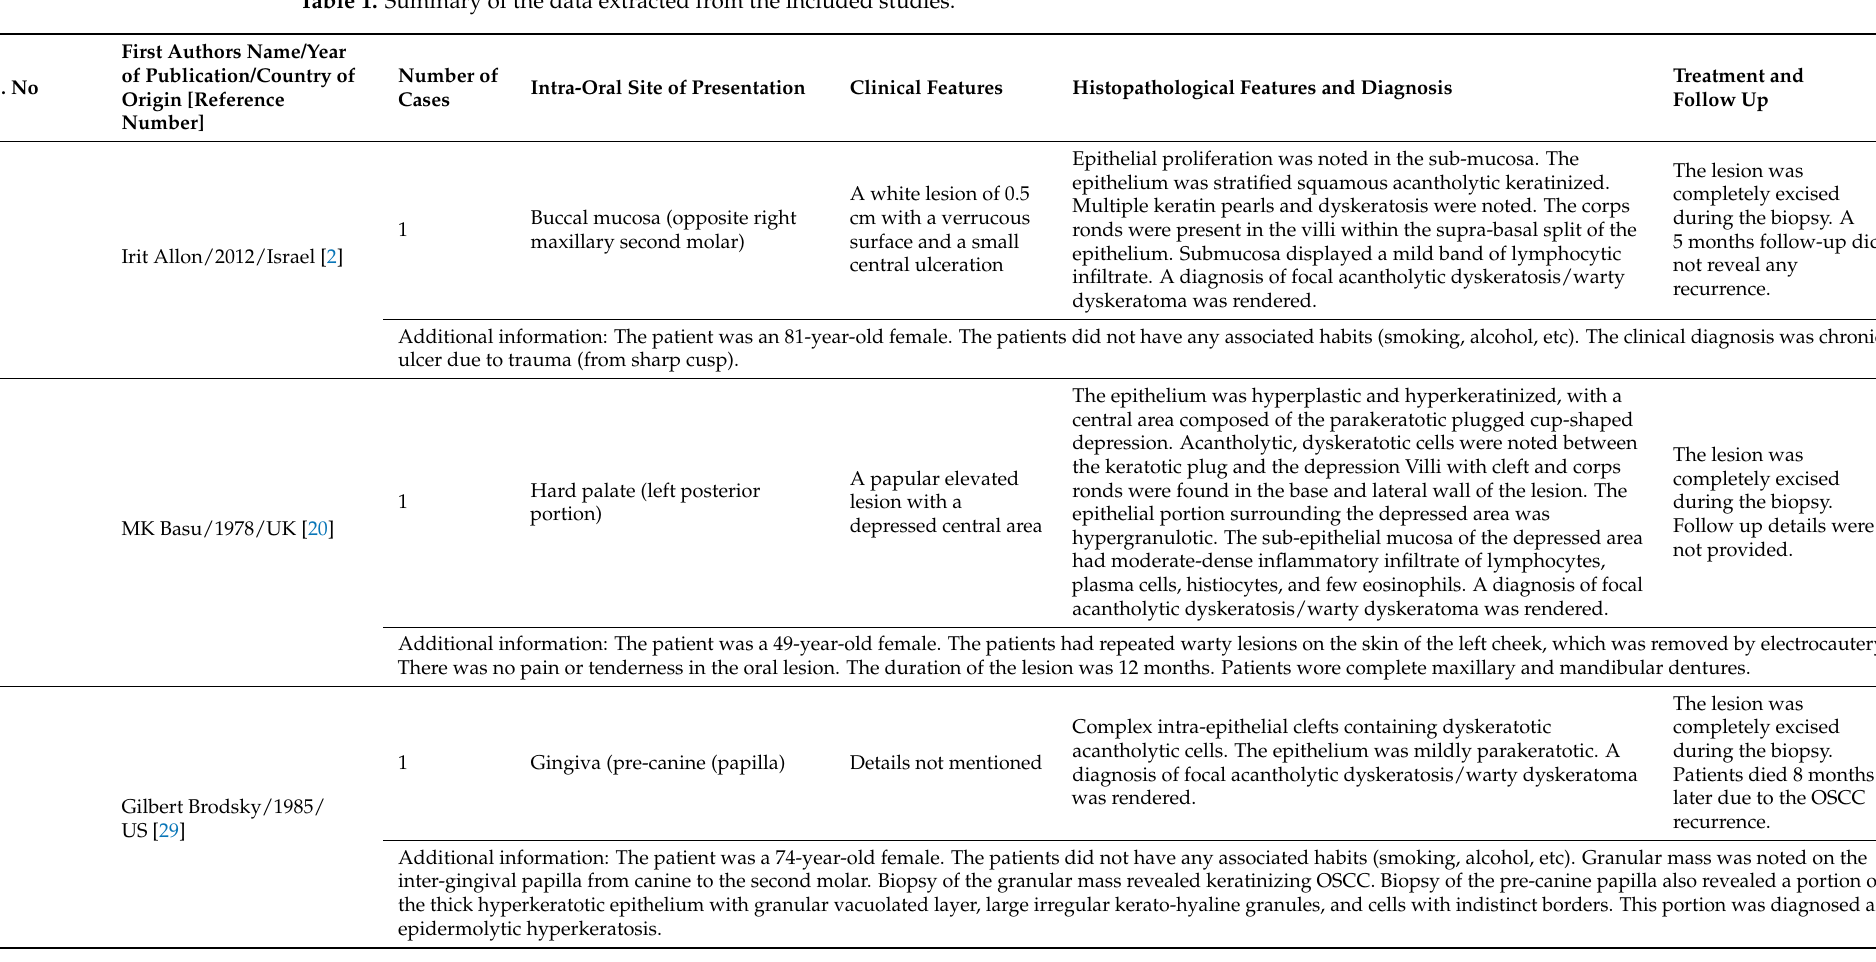
Table 1. Summary of the data extracted from the included